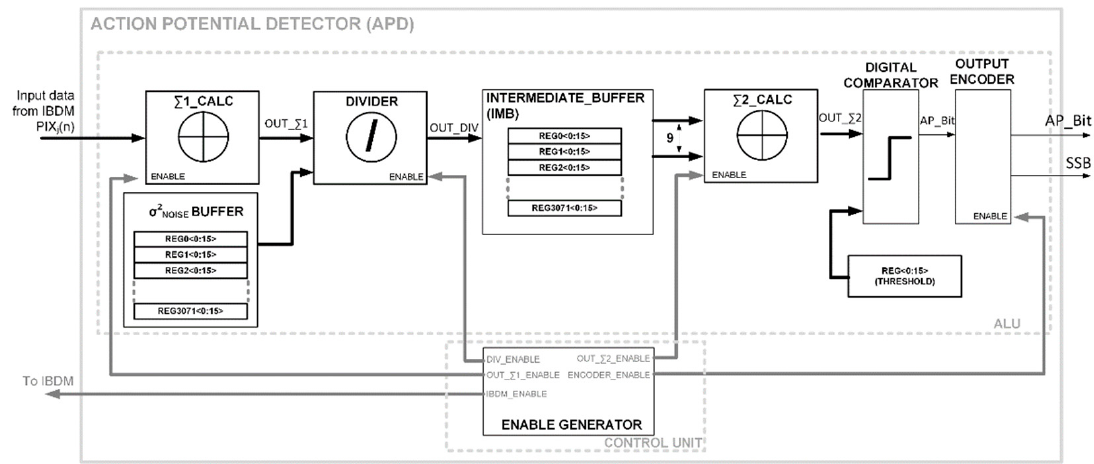
Figure 10. Action potential detector (APD) block scheme.